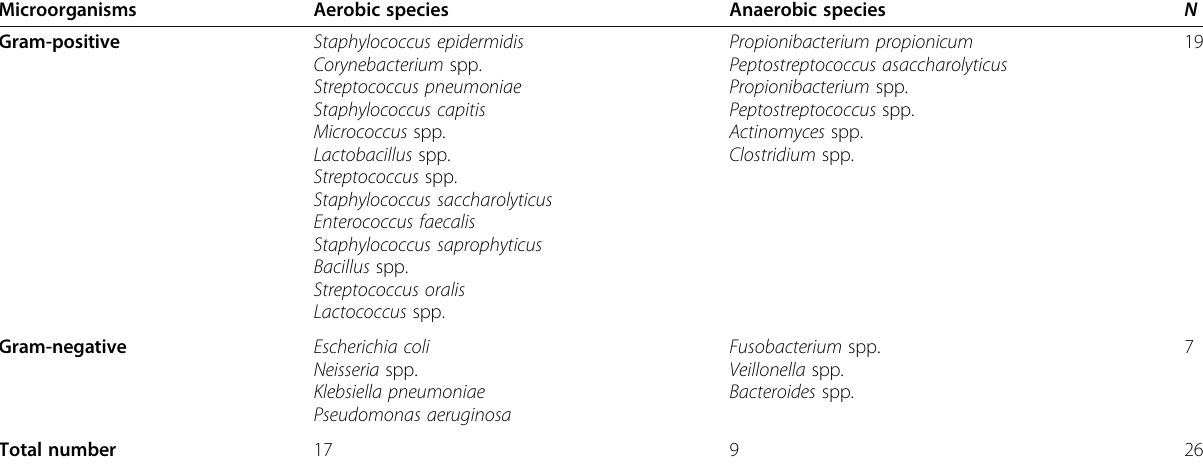
Table 1 Various microorganisms isolated from the collected bone after culture